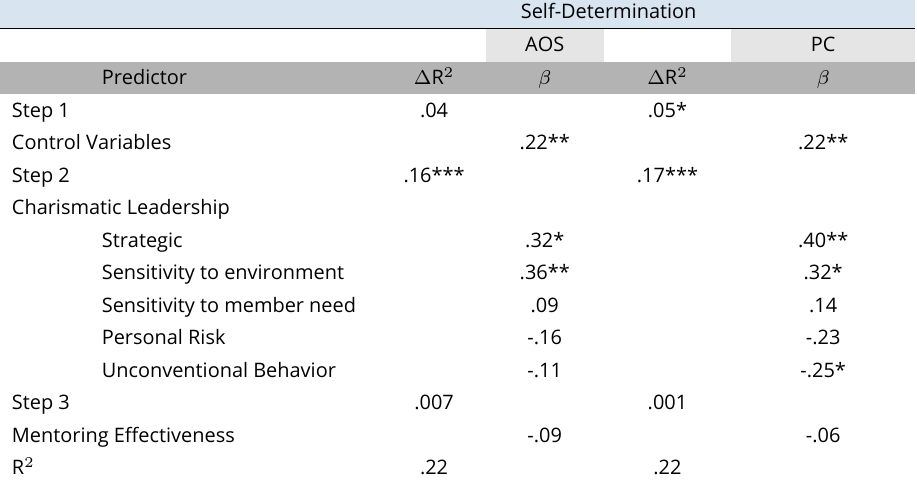
Hierarchical Multiple Regression Analysis Predictors of Awareness Oneself and Perceived Choice